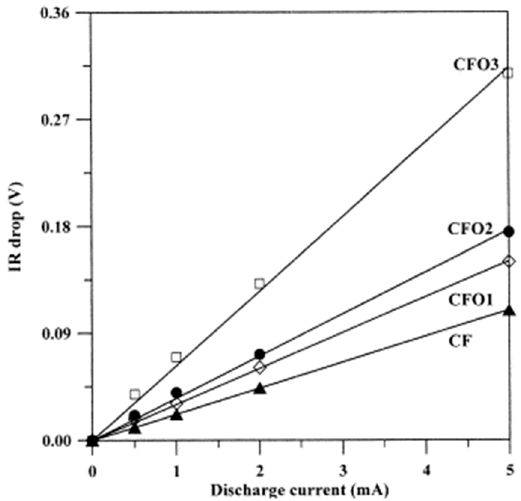
Figure 26. Variation of IR drop with discharge current for the parent (CF) and oxidized (CFOx) activated carbon fibers tested in 1 mol L − 1 H 2 SO 4 as an electrolyte. Reproduced from [174] with permission from Elsevier © 2002.